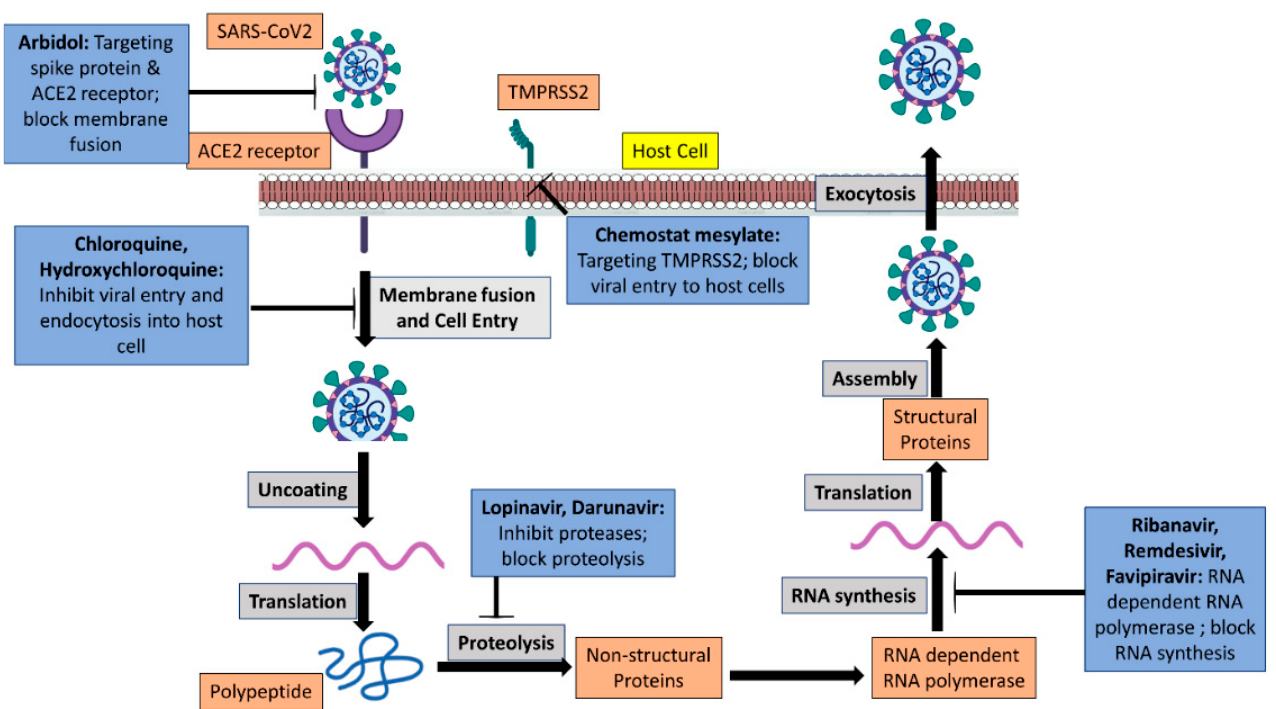
Figure 2. Antiviral drugs and their mode of action against SARS-CoV-2.